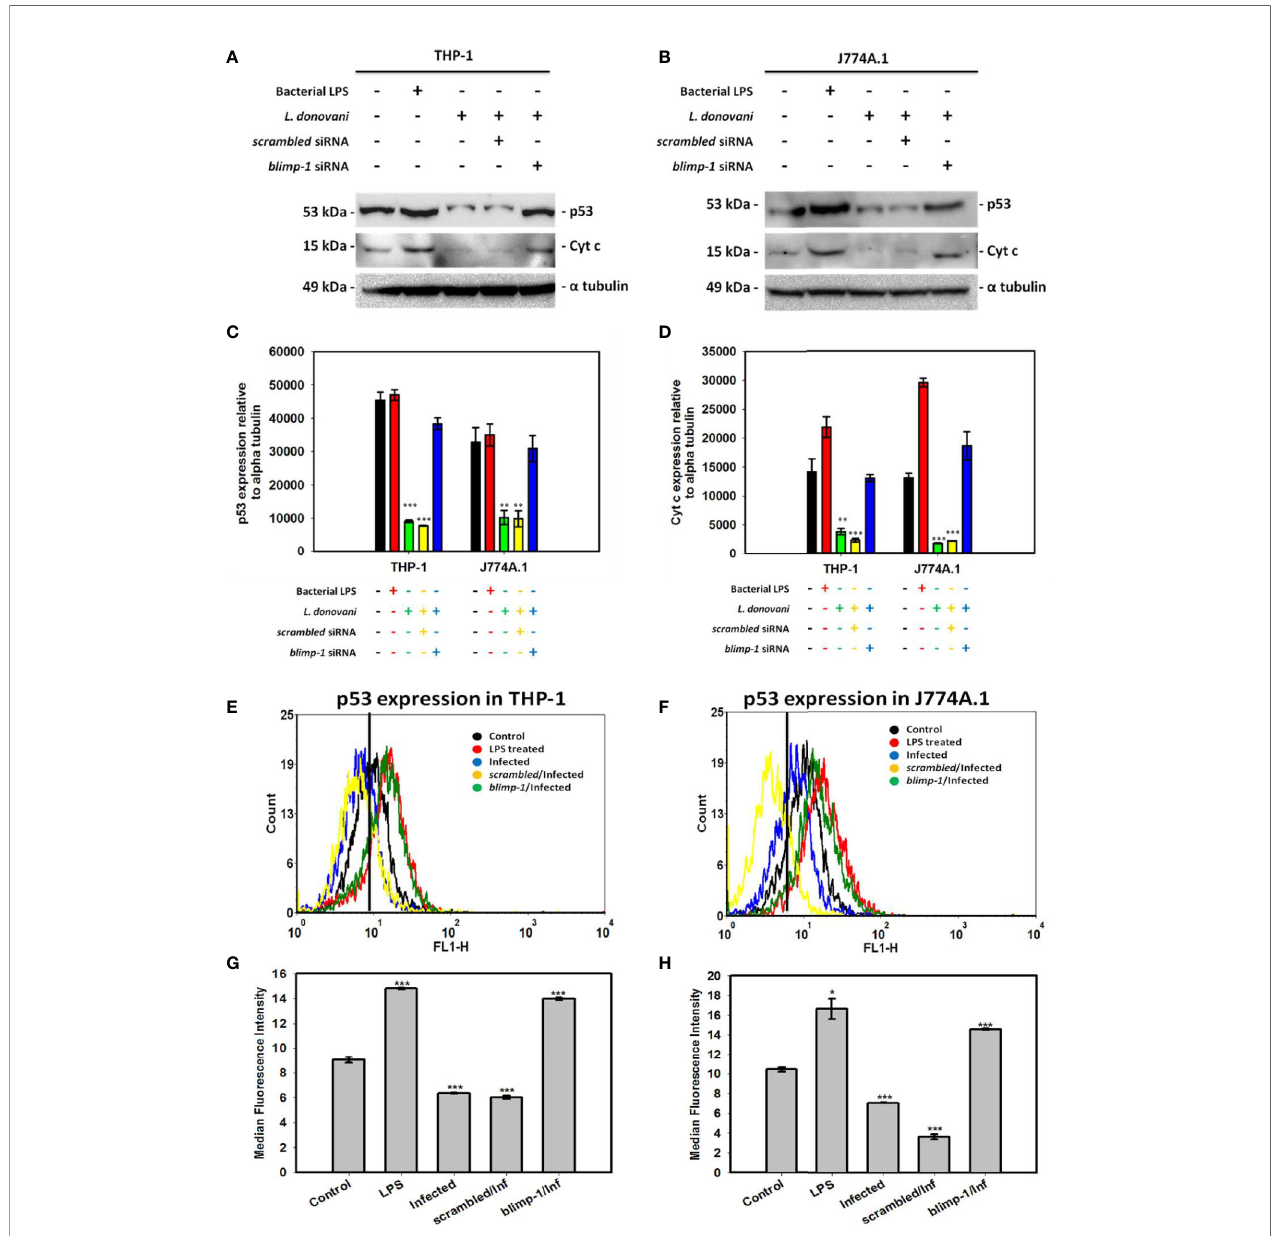
FIGURE 3 | Quanti fi cation of p53 expression in blimp-1 de fi cient cells infected with promastigotes at MOI of 1:5 for 24 h in both THP-1 and J774A.1 cell lines were measured using immunoblotting and fl ow cytometry. Immunoblot of p53 and Cyt c were shown in (A) THP-1 cells and (B) J774A.1 cells along with densitometry analyses in (C) THP-1 and (D) J774A.1 cells. For fl ow cytometry, overlaid histogram plot for p53 was shown in (E) THP-1 cells and (F) J774A.1 stained cells. Median Fluorescence Intensity (MFI) has also been plotted in (G) THP-1 and (H) J774A.1 cells.(Note: n = 3, where n represents three different independent experimental replicates for all the experiments; * denotes p < 0.05, ** denotes p < 0.005, and *** denotes p < 0.001; percentage of gated cells is 100% and total event counted is 2,500 for all fl ow cytometry